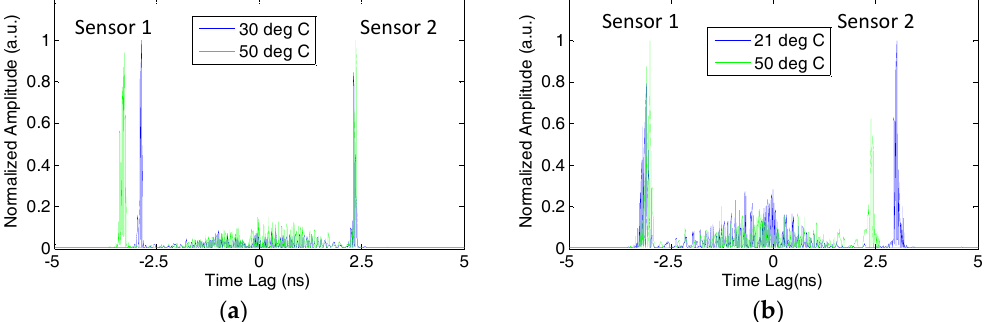
Figure 14. Correlation signals (compressed pulses) for the waveforms measured when LCFBG 1 is at 30 °C (Figure 2a) and 50 °C (Figure 2b). Correlation signals (compressed pulses) for the waveforms measured when LCFBG 2 is at 21 °C (Figure 4a) and 50 °C (Figure 4b) (after Reference [13]).